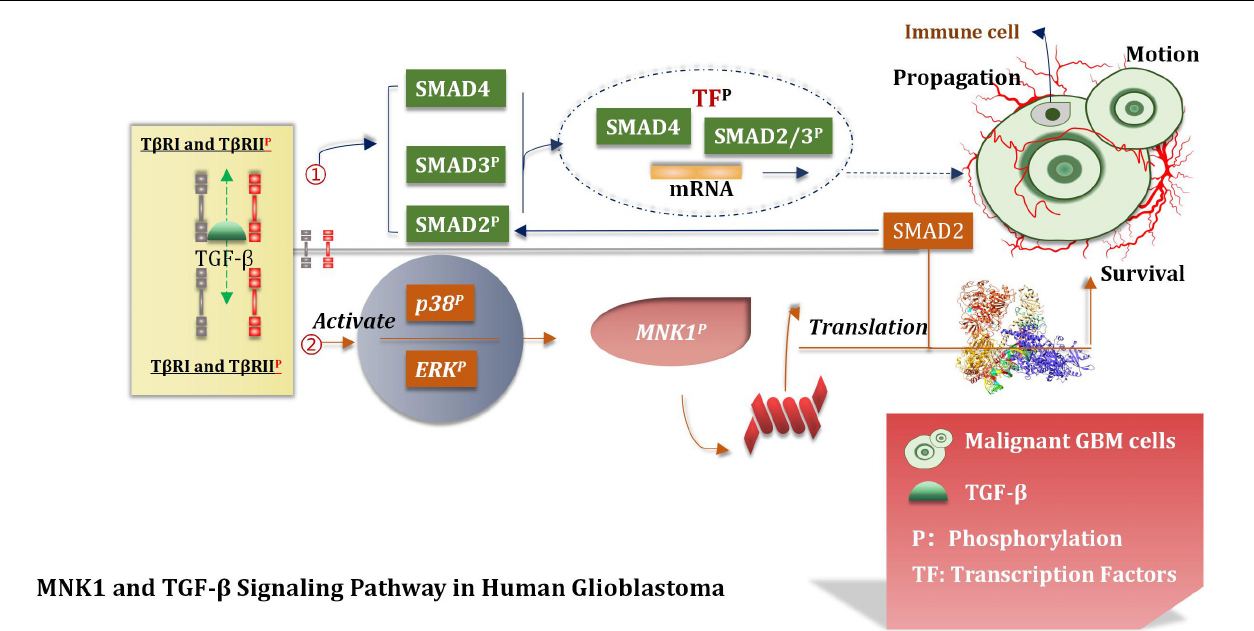
FIGURE 9 | TGF- β signal pathway. TGF- β pathway interacts with TF to induce the expression of GBM cell proliferation, motility and survival genes, and participates in the translation of tumor